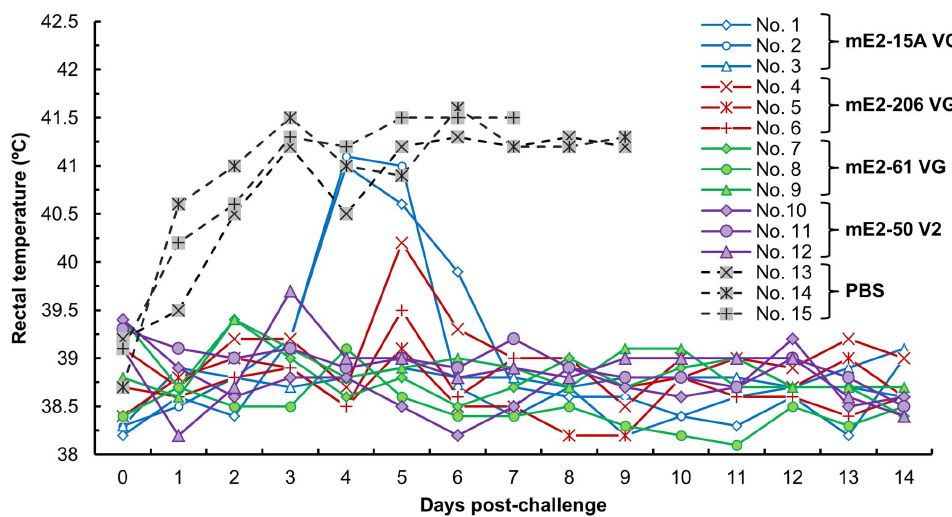
Figure 7. Rectal temperatures post-challenge. Vaccinated and control pigs were challenged with the virulent CSFV Shimen strain. After challenge, rectal temperatures of each pig were measured daily for 14 days.